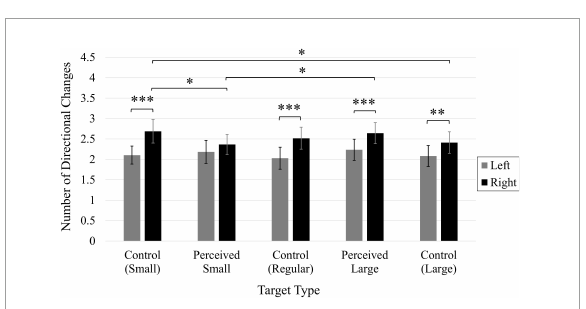
95% CI [16817.29, 21012.08]) than when presented on the left ( M = 14706.17 px, 95% CI [13299.45, 16112.90]).